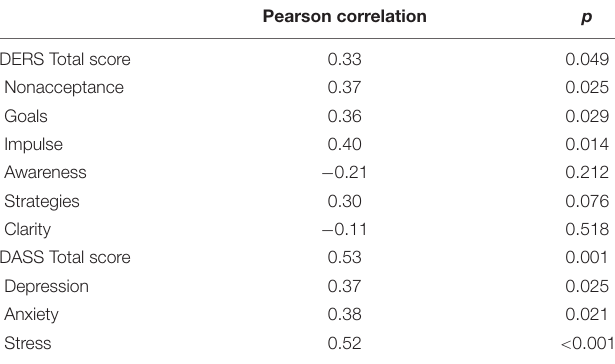
TABLE 4 | Correlation with perceived driving